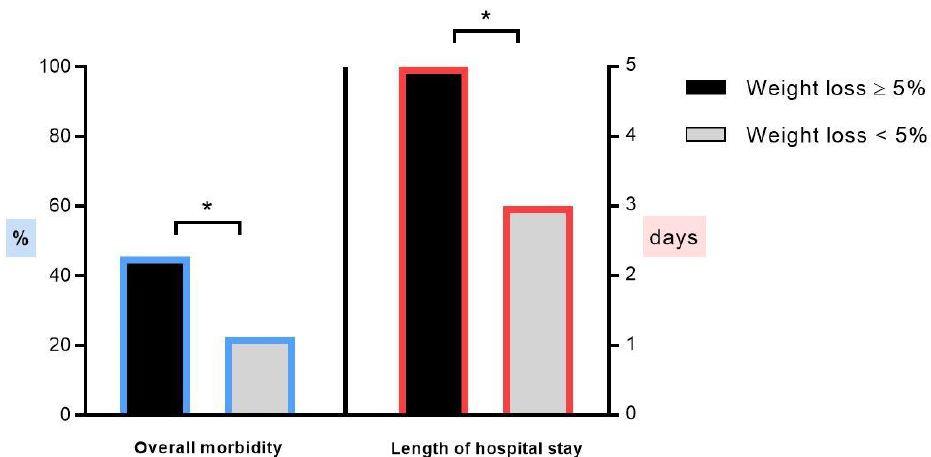
Figure 2. Comparison of postoperative morbidity and length of hospital stay in patients with preoperative weight loss ≥ 5% within 6 months of surgery ( n = 33, black bars) and patients with < 5% weight loss ( n = 306, grey bars). Asterisk (*) indicates statistical significance ( p < 0.05).